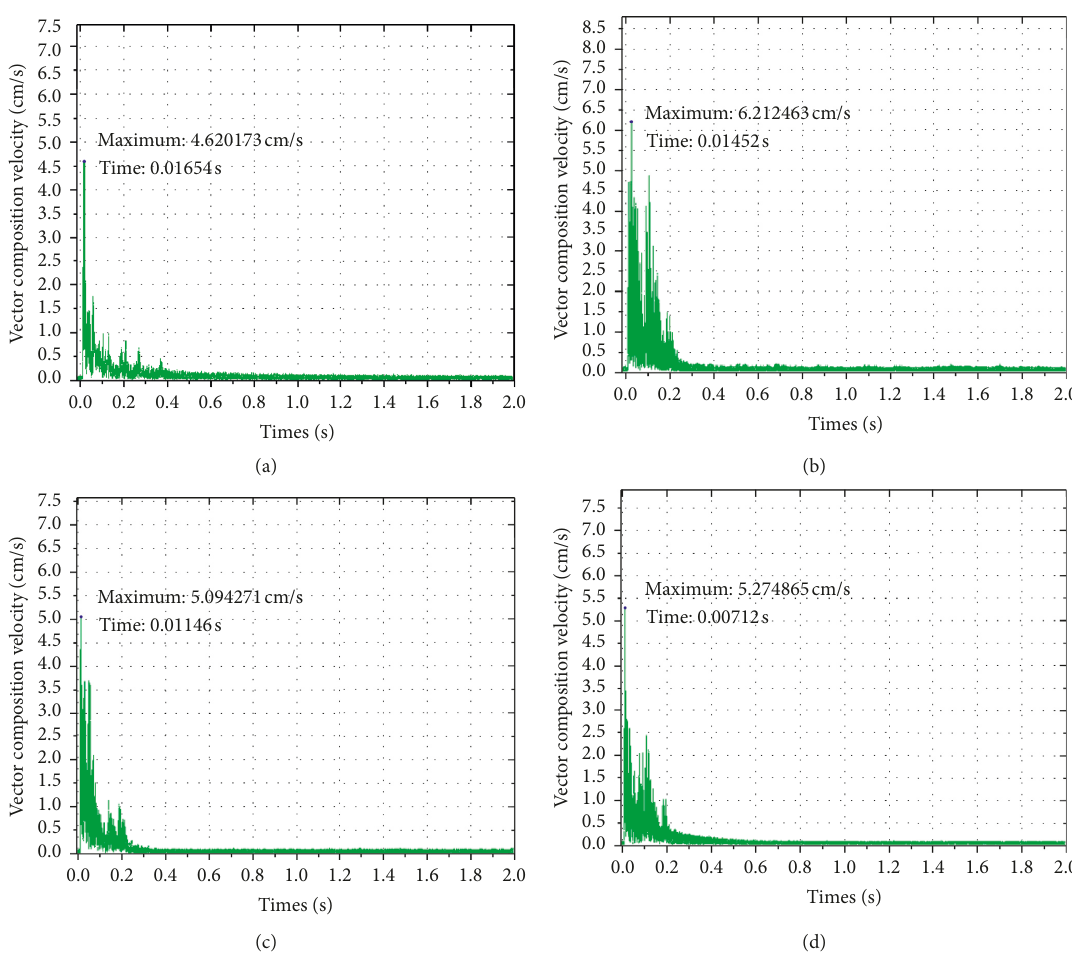
Figure 6: Time-history curve of vibration velocity at Point C during blasting of Section I (a), Section II (b), Section III (c), and Section IV (d). Table 1: Vibration monitoring data of Jia Hua Tunnel Left